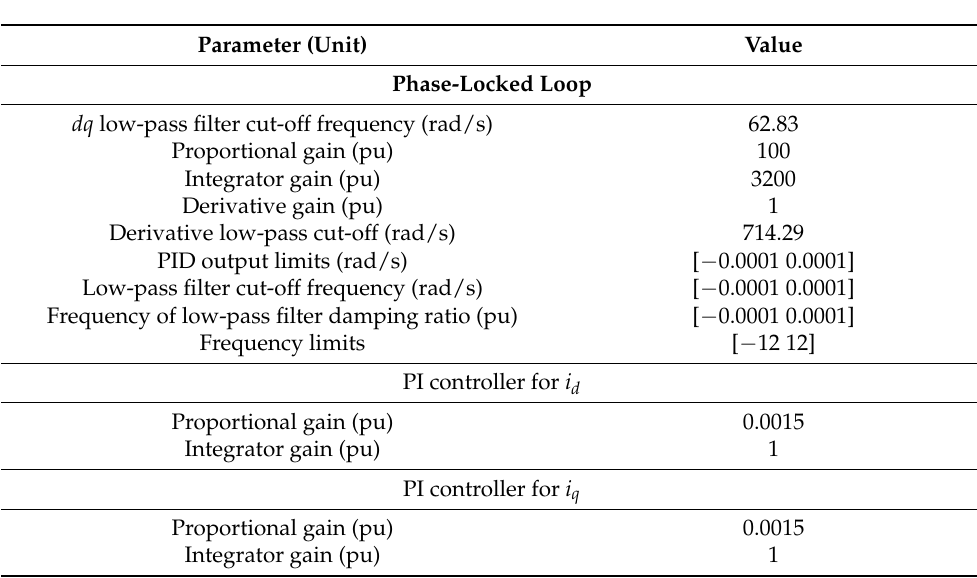
Table 4. Parameters of the